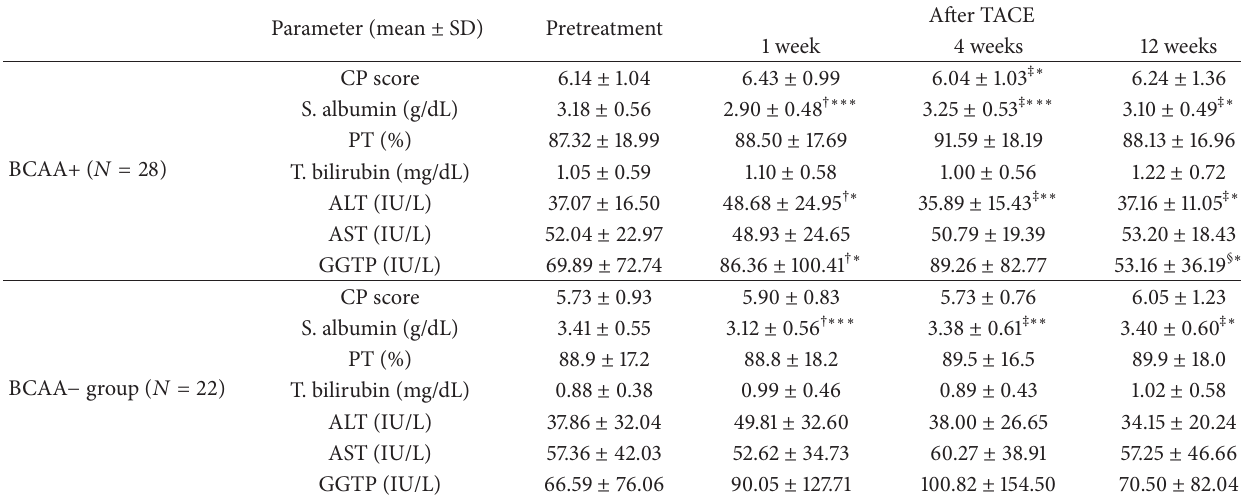
Table 5: Subgroup analysis in BCAA+ and BCAA −